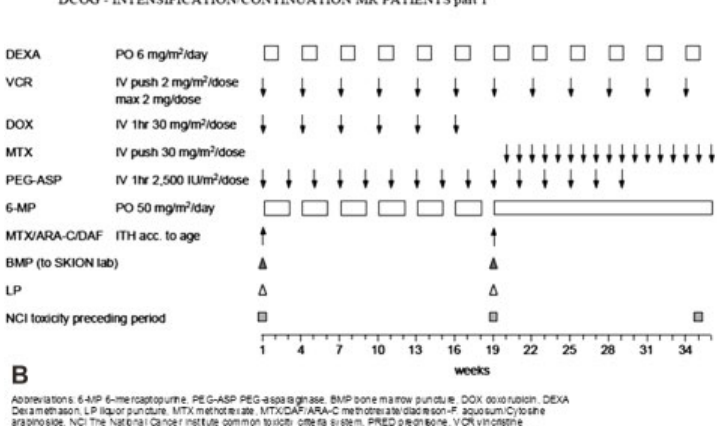
Fig. 2 ( A ) DCOG ALL-10 induction protocol 1A and B. ( B ) DCOG intensi fi cation/continuation MR patients part I. ALL, acute lymphoblastic leukemia; DCOG, Dutch Childhood Oncology Group, MR, medium risk.